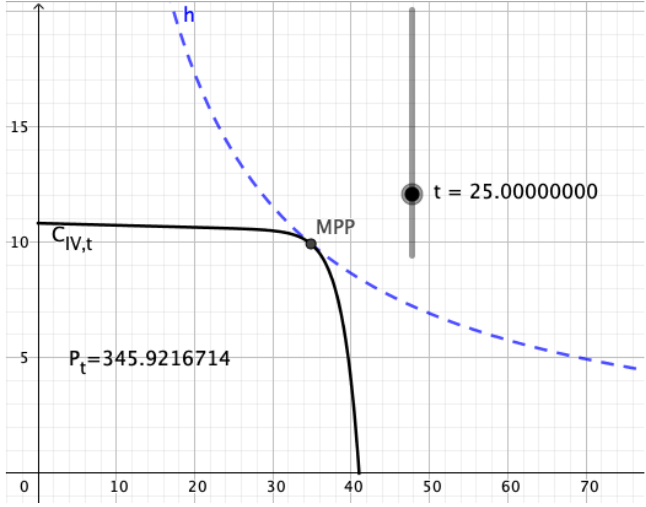
Figure 3. The slider allows temperature t to be changed between 0 ◦ and 100 ◦ C.